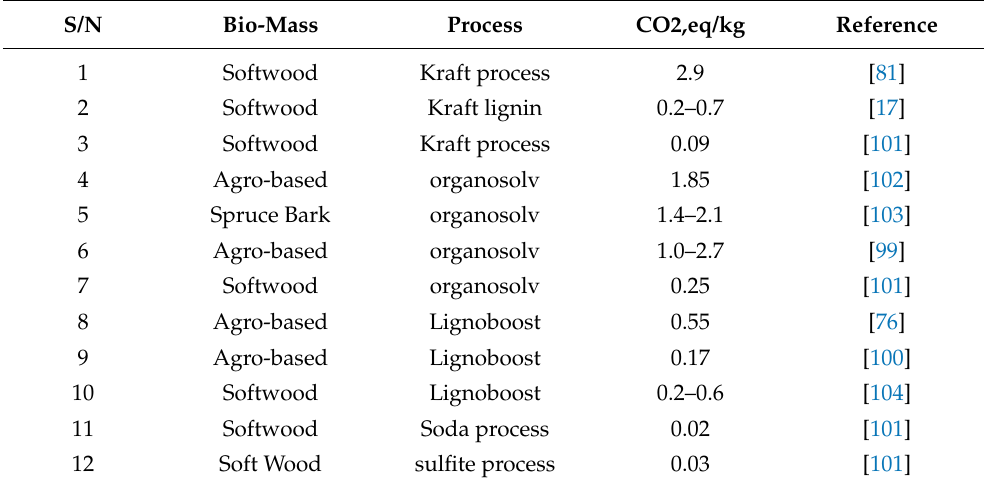
Table 2. Contribution of process step carbon